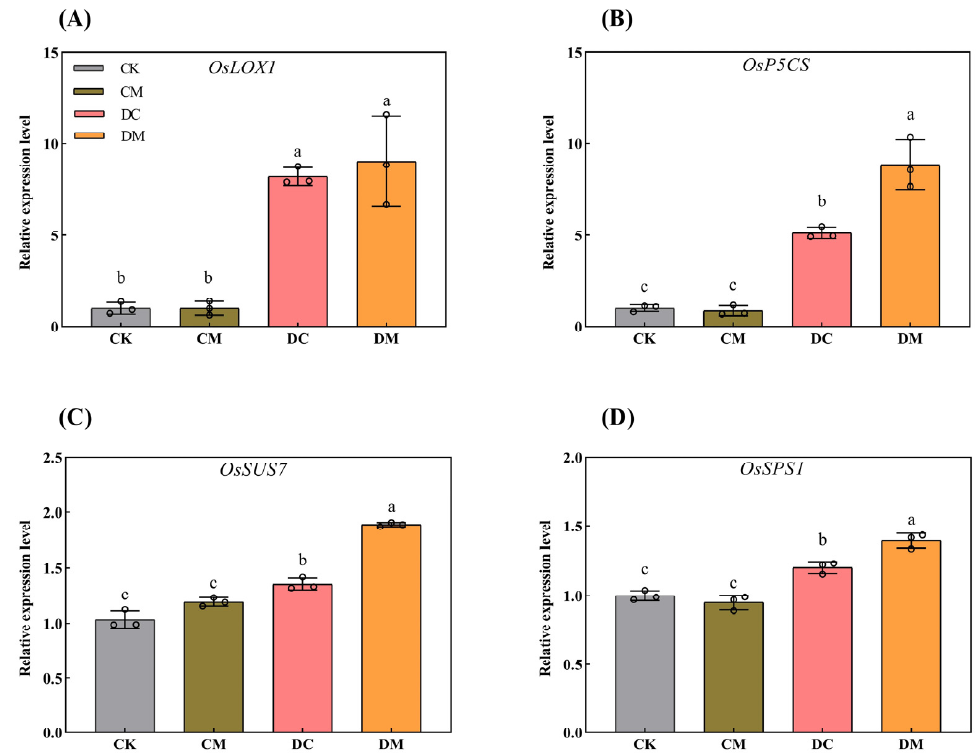
Figure 6. Effect of exogenous melatonin on LOX synthesis and osmotic adjustment-related gene expression levels under drought stress. ( A ) OsLOX1 expression level; ( B ) OsP5CS expression level; ( C ) OsSUS7 expression level; and ( D ) OsSPS1 expression level.